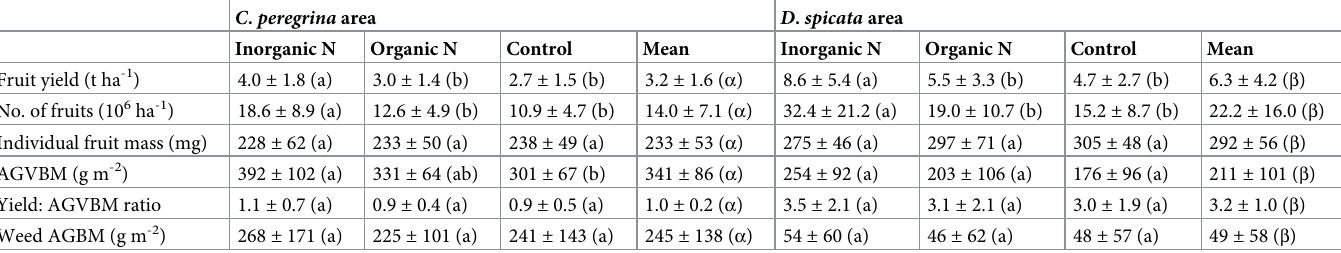
Table 2. Average values ( ± SD) of the measured variables for blueberry and weeds in plots colonized by C . peregrina and D . spicata subjected to the three fertiliza- tion treatments. Measured variables included lowbush blueberry fruit yield (t ha -1 ), number of fruits produced (10 6 ha -1 ), individual fruit mass (mg), aboveground vegeta- tive biomass (AGVBM; g m -2 ), fruit yield: aboveground vegetative biomass ratio, and weed aboveground biomass (AGBM; g m -2 ) under the three N-fertilization treatments in plots having C . peregrina or D . spicata as companion weed species. Values not sharing the same letters are significantly different ( P < 0.05). Roman letters are used to compare N-fertilization treatments, whereas Greek letters are used to compare the two areas of the field (i.e., C . peregrina area vs. D . spicata